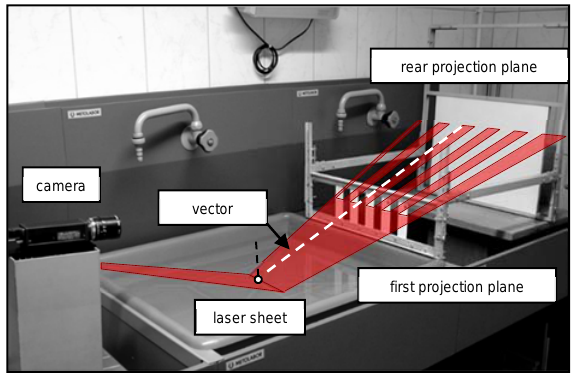
Figure 6: System layout with vertical grid as first projection plane and principle of profile point